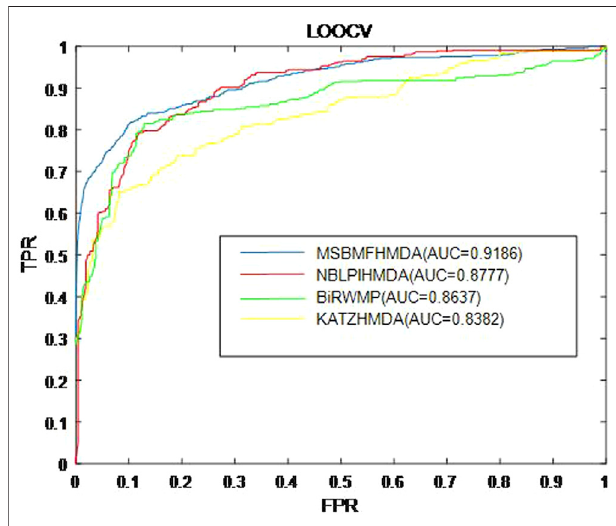
FIGURE 2 | Prediction performance comparison between MSBMFHMDA and the other three methods in leave-one-out cross validation (LOOCV).